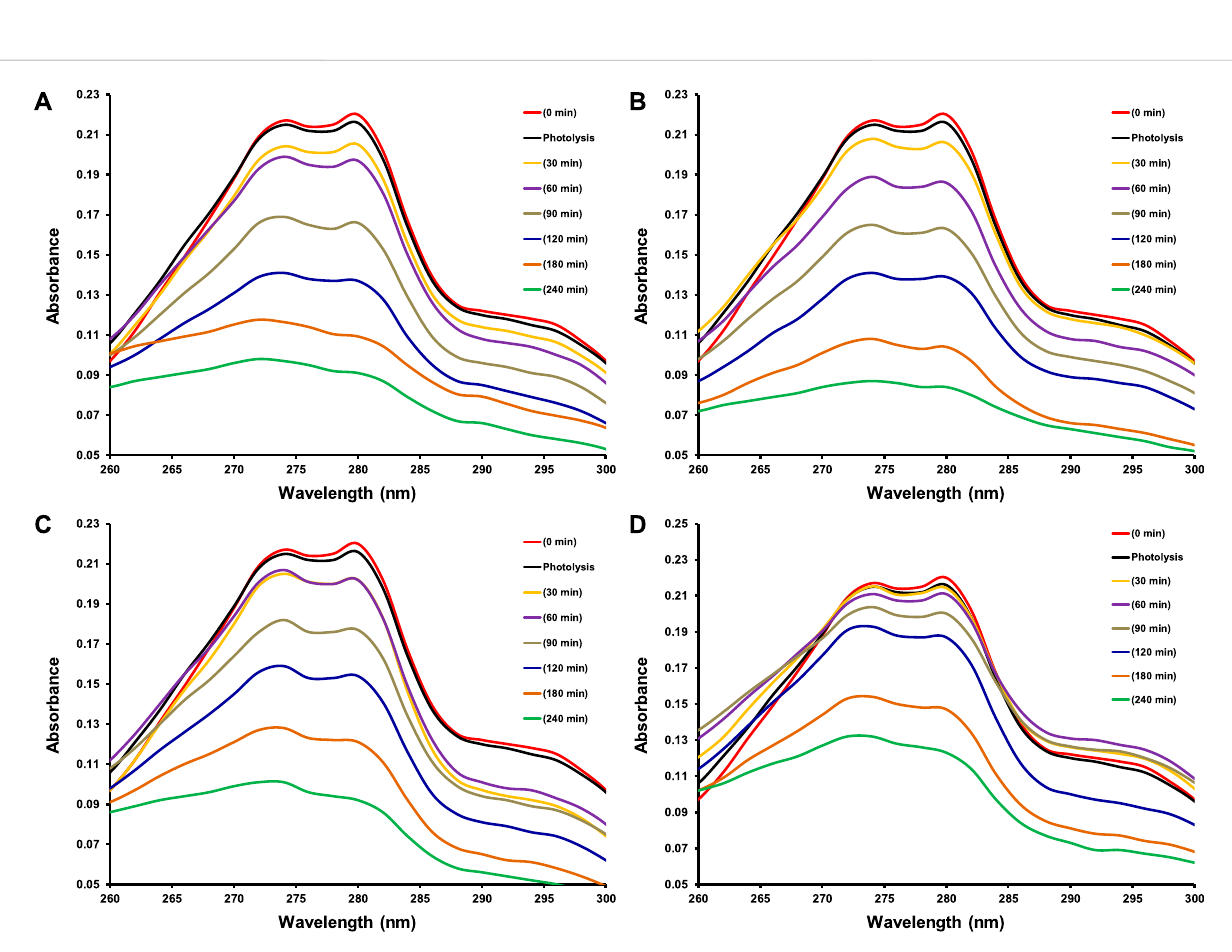
FIGURE 6 Thecomparisonofabsorption spectra forphotocatalyticdegradationof15 ppm2-CPover (A) CeO 2 (B) FedopedCeO 2 (C) CudopedCeO 2 and (D) Ni doped CeO 2 at different intervals of time under the illumination of indoor white light (800 × 10 2